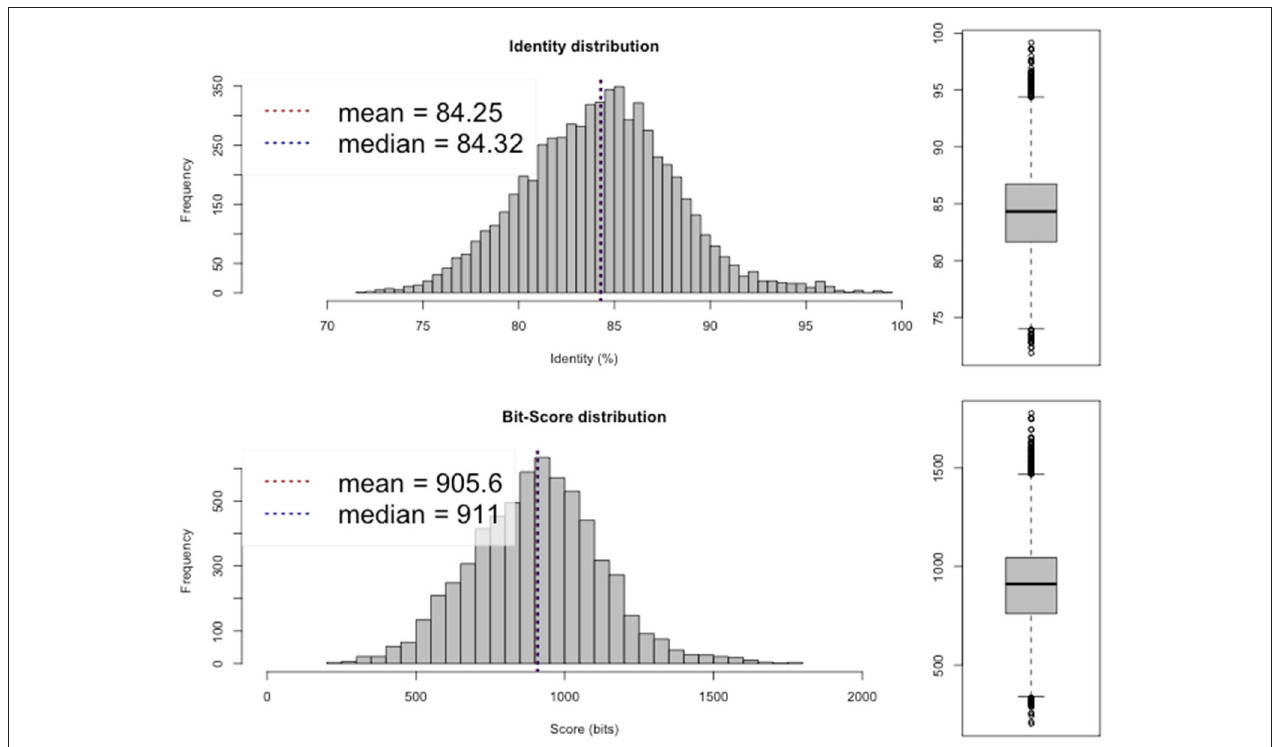
FIGURE 1 | Average Nucleotide Identity (ANI) plot between R. sullae IS123 T and R. etli